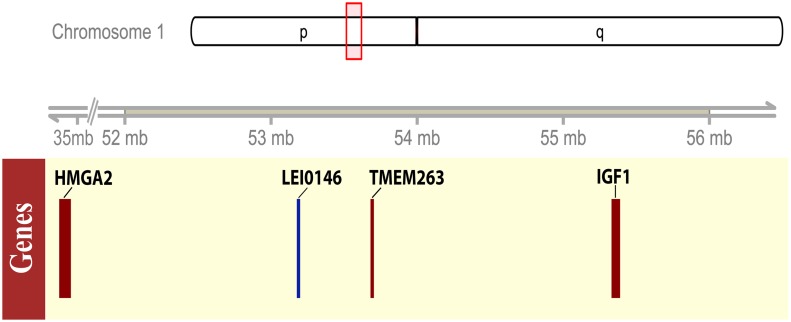
Schematic representation of the candidate region for adw locus on chromosome 1. The upper panel showed the ideogram of the chicken chromosome 1, the candidate region, 52–56 Mb, was shown by a red box on the ideogram tracks. The lower panel showed the gene model by the solid box, indicating the size of the coding region of the representative candidate genes or the microsatellite marker. The associated microsatellite marker LEI0146 was plotted in blue, while the genes with interest, HMGA2, TMEM263, IGF1, presented in red boxes.